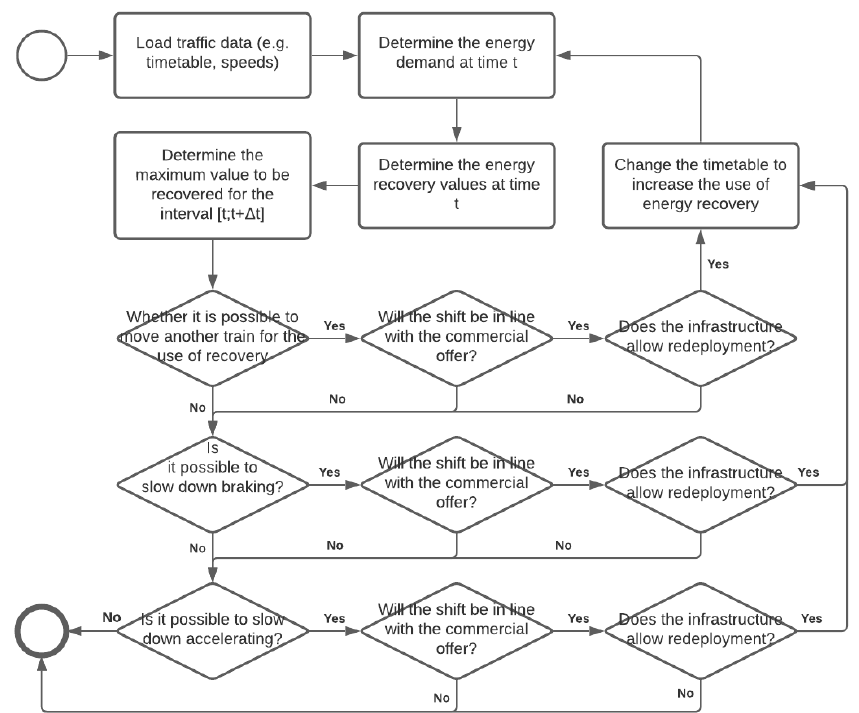
Figure 3. A timetable reconfiguration algorithm that takes into account the increased level of con- sumption of recovered electricity.